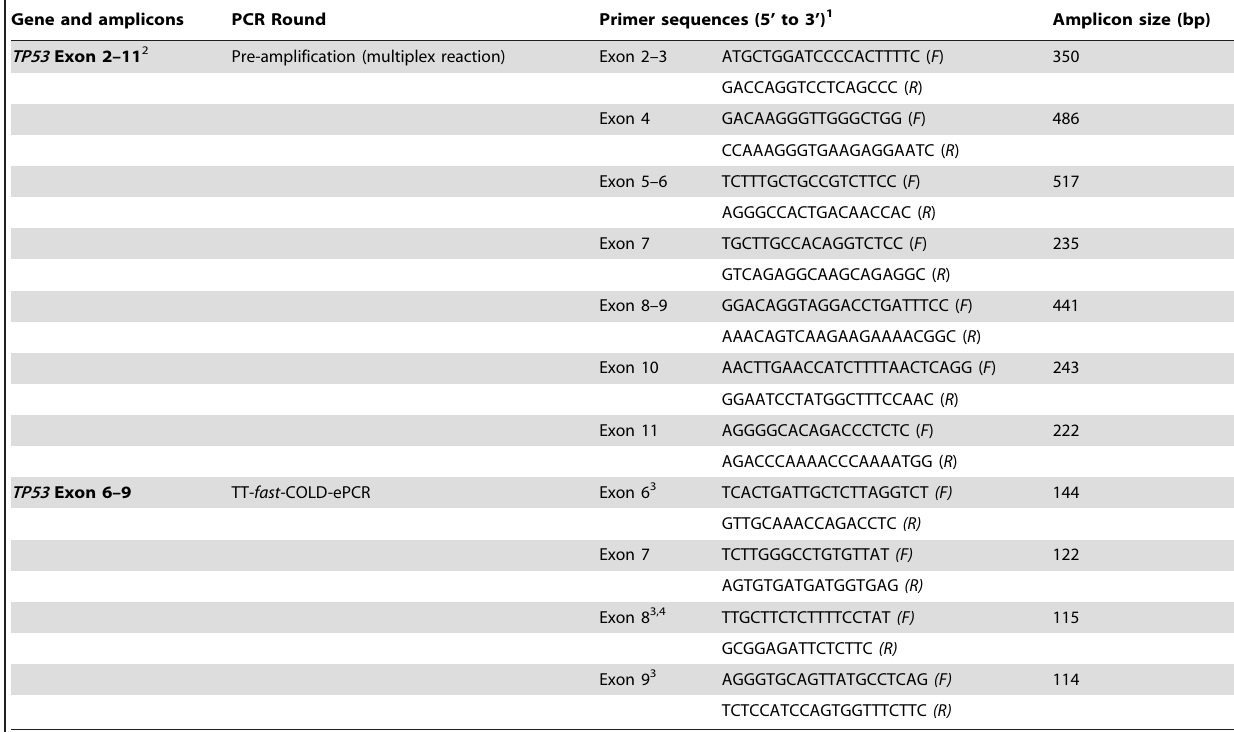
Table 2. Primer sequences used in this